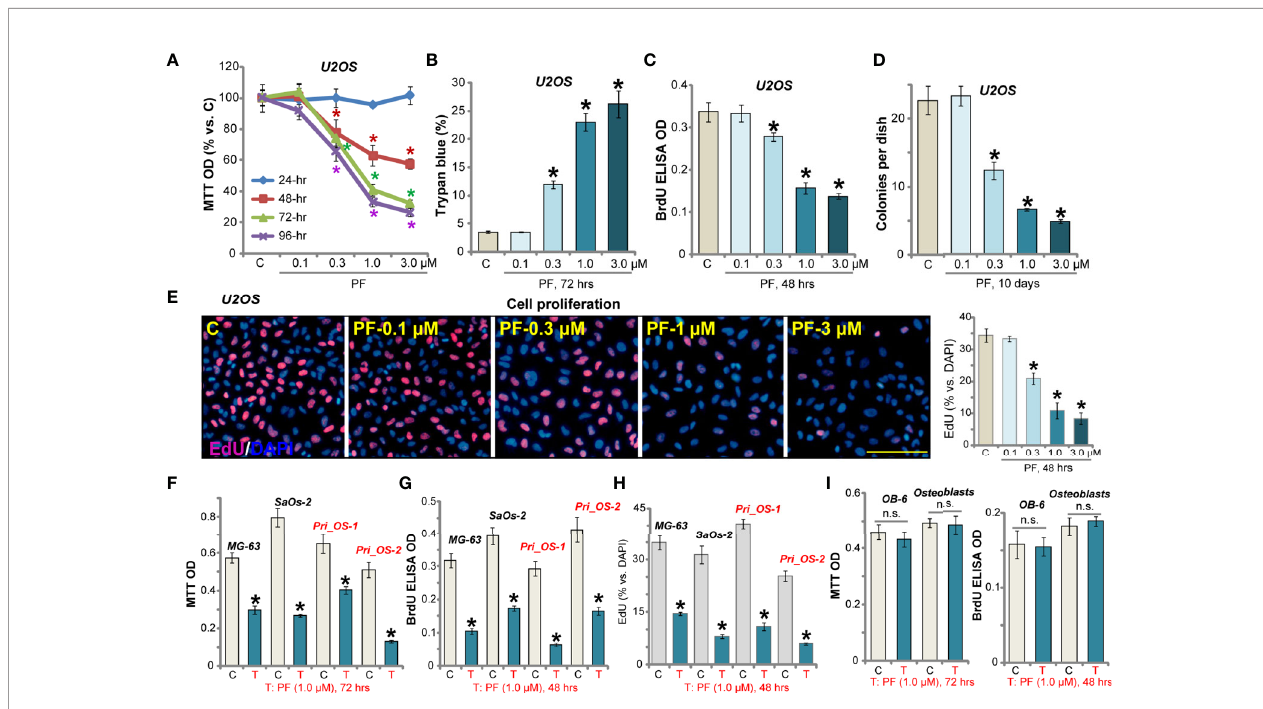
FIGURE 1 | PF-06409577 inhibits human OS cell viability and proliferation. U2OS cells (A – E) , MG-63 cells, SaOs-2 cells (F – H) , primary human OS cells ( “ Pri_OS-1/-2 ” ) (F – H) , OB-6 cells ( “ OB-6 ” ) (I) , or primary human osteoblasts ( “ Osteoblasts ” ) (I) were treated with applied concentration of PF-06409577 ( “ PF ” ) for indicated time periods. Cell viability, death, and cell proliferation were analyzed by the methods mentioned in the text. “ C ” stands for cells left untreated for indicated time (same for all fi gures). For each assay, n = 5 ( fi ve replicate wells/dishes). Data were presented as mean ± standard deviation (SD). * p < 0.05 vs. “ C ” cells. “ n.s. ” stands for non-statistical difference (same for all fi gures). Experiments were repeated three times, and similar results were obtained each time. Scale bar = 100 m m (E)